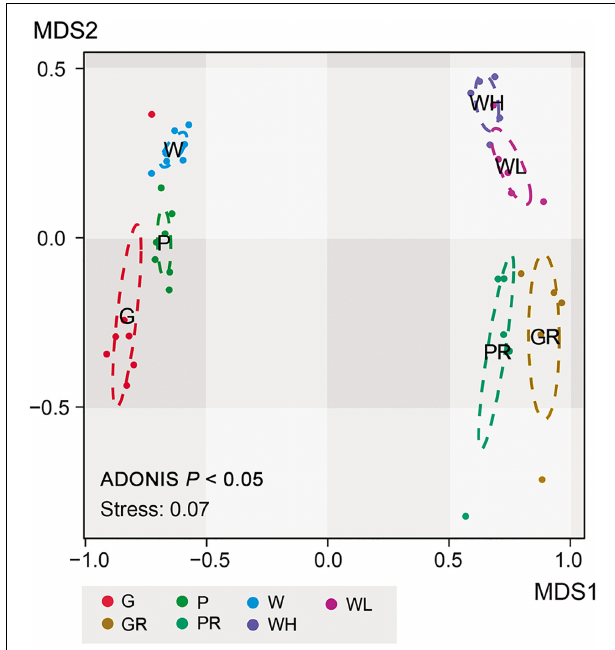
FIGURE 8 | NMDS ordination of 21 samples in Ming Lake and 20 samples in Pearl River, showing clustering into groups according to environments (Ming Lake or Pearl River) and sample types (glass slides, PFUs and water columns). G, glass slides samples from lake; P, PFU samples from lake; W, water column samples from lake; GR, glass slides samples from river; PR, PFU samples from river; WH, water column samples at high tide from river; WL, water column samples at low tide from river. The ellipses represent 95% confidence intervals. P represents significance between every two sample types based on ADONIS